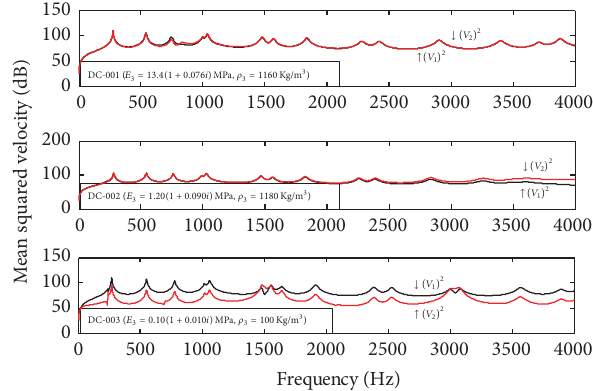
Figure 4: Comparison of the mean squared velocities of the base plate and the outer surface ( V 2 2 ) of the decoupling layer for the three specimens.